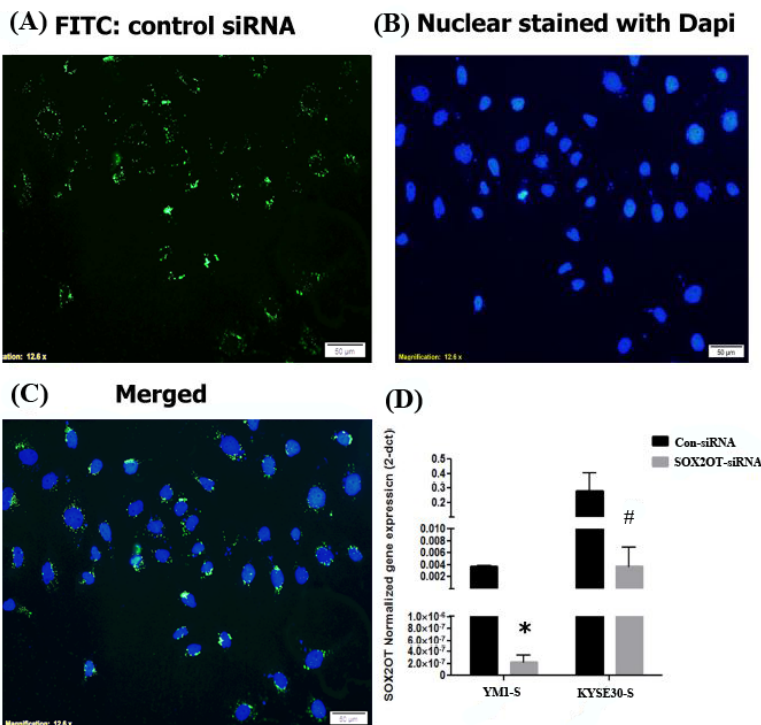
Figure 4. SOX2OT knockdown in ESCC cells. Fluorescence imaging of the FITC-scrambled siRNA transfected ESCCs. The transfected siRNA is shown in green ( A ) and nuclear is stained with dapi in blue ( B ) color. The merged image is shown in ( C ). The quantitative gene expression assessment demonstrated significant downregulation of the SOX2OT in siRNA-transfected YM1-S and KYSE30-S tumorspheres in comparison to the control scrambled siRNA-transfected tumorspheres ( D ). YM1-S: YM1 sphere, KYSE30-S: KYSE30 sphere, * p -value = 0.017 and # p -value = 0.05. bars represent mean ± SE.